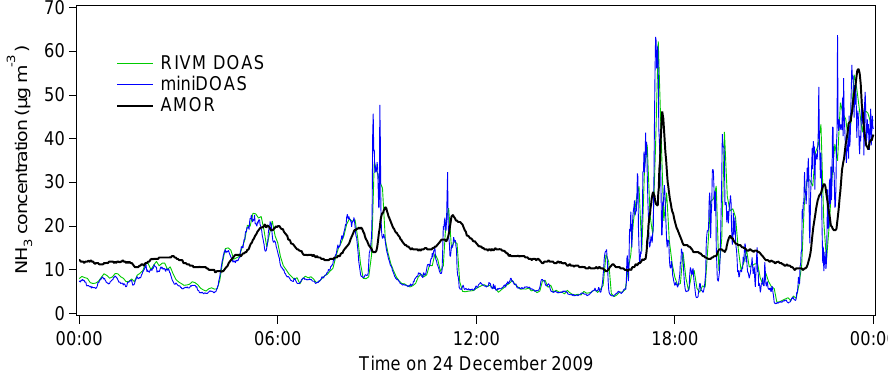
Fig. 17. RIVM DOAS (5-min values), miniDOAS (1-min values), and AMOR data (1-min values) obtained in the field in Vredepeel from 21 to 28 December 2009.